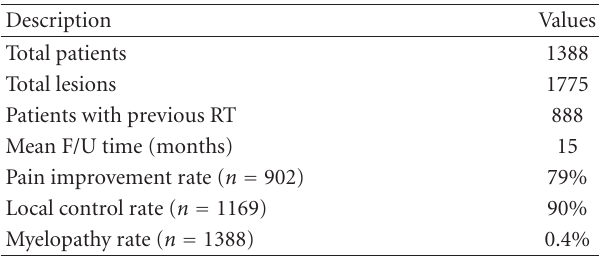
Table 2: Pooled results of spinal radiosurgery